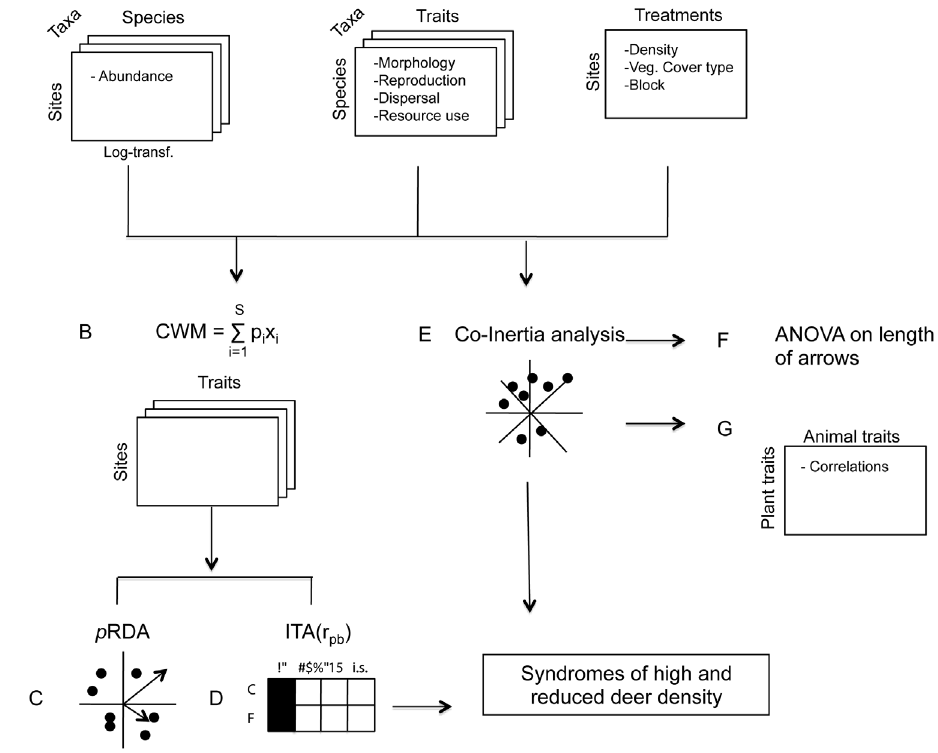
Figure 1. Diagram of the statistical approach. Sequence of the statistical analyses used to assess the functional syndromes of plant and animal traits associated with deer density. Distinct matrices were used for plants, ground beetles and songbirds (A). The matrix Treatment was the same for each group with the variables vegetation cover type (uncut forests and cut-over areas), deer density and block (A). The matrices CWM (community weighted mean) of traits by sites combine the Abundance (p i ) and Trait (x i ) matrices using weighted averaging (B). The partial redundancy analysis ( p RDA; C), indicator traits analysis (ITA; D) and co-inertia analysis (E) were conducted with the CWM matrices. The impact of deer density on the degree of association of functional traits between two taxonomic groups (length of arrows in co-inertia graph) was tested with ANOVA (F). Finally, a correlation matrix between plant and animal traits was calculated (G) doi:10.1371/journal.pone.0090437.g001 PLOS ONE |